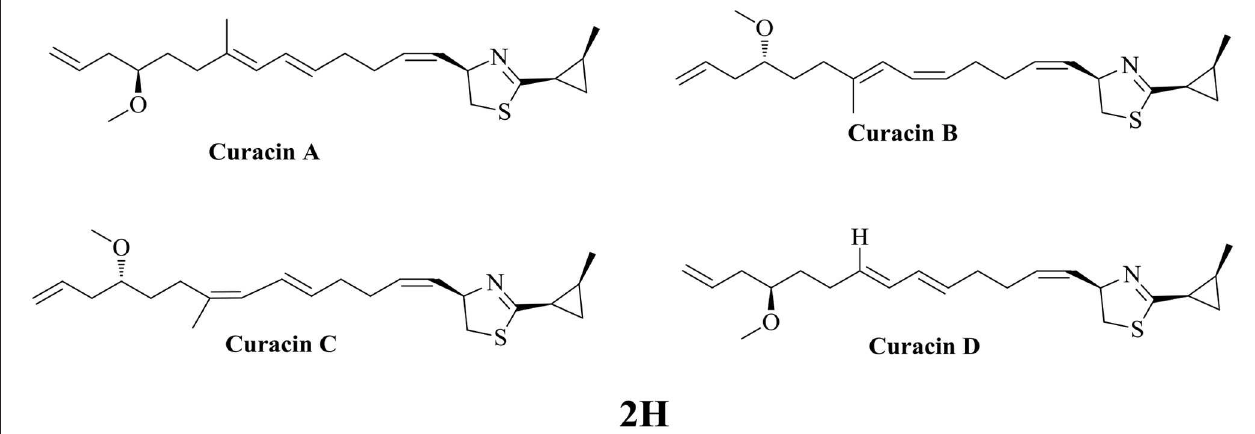
FIGURE 2 | Chemical structures of bioactive molecules from Lyngbya . (A) Lagunamides, (B) Trungapeptins, (C) Apratoxins, (D) Lyngbyabellins, (E) Pitipeptolides, (F) Lyngbyalosides, (G) Biselyngbyasides, (H) Curacins.